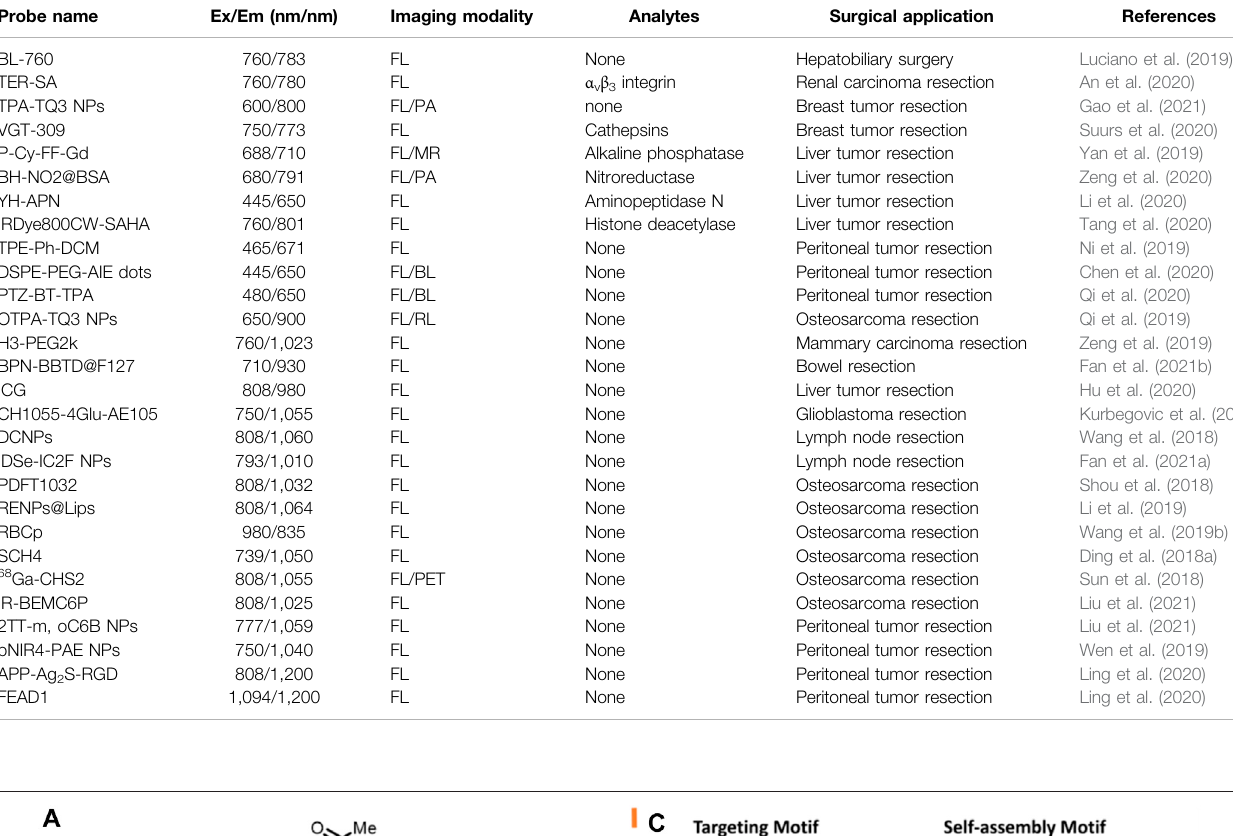
TABLE 1 | Summary performance comparison of fl uorescence image-guided surgery dye platforms. Probe name